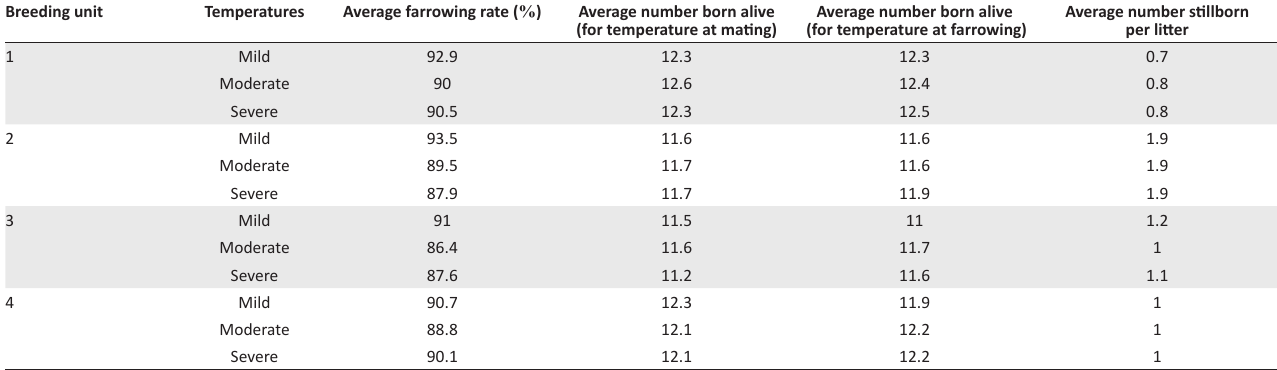
TABLE 1: Average data for farrowing rate, piglets born alive and stillborn in relation to temperature. Mild temperature < 22 °C; moderate temperature 22 °C – 30 °C; severe temperature > 30 °C. Breeding unit